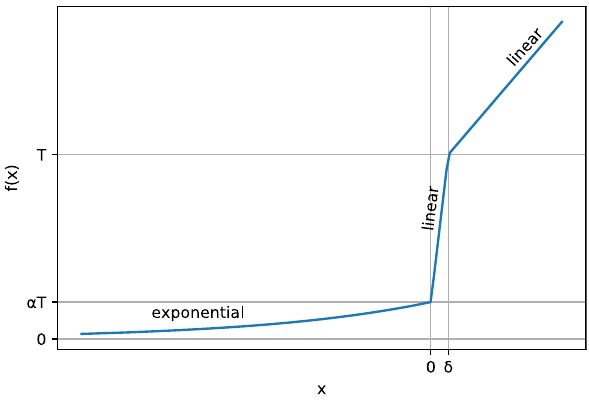
Fig. 2 Activation function f ( x ) as defined in Eq.